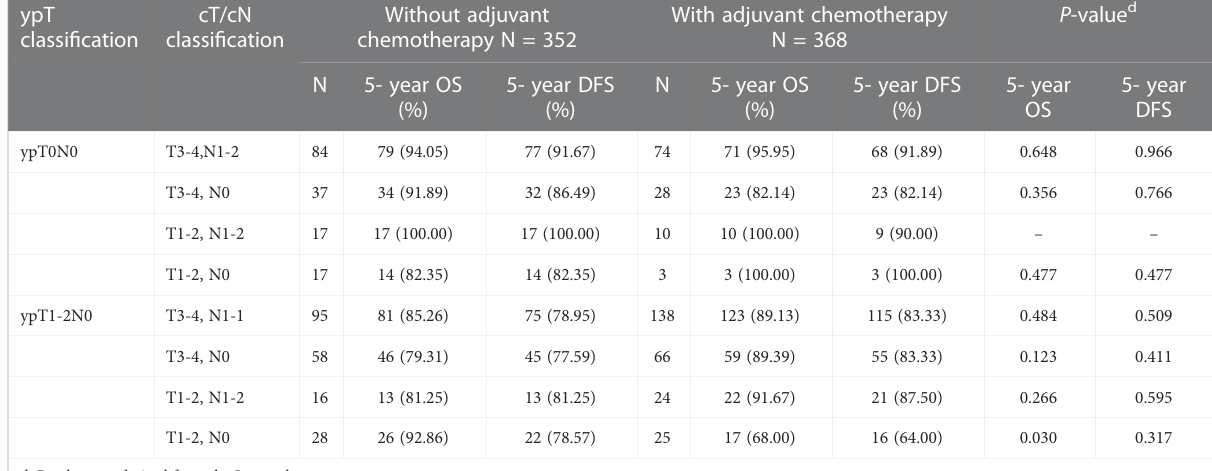
TABLE 3 5-year OS and DFS comparison by different clinicopathological stage and the use of adjuvant chemotherapy of study patients, n =720. ypT cT/cN Without adjuvant classi fi cation classi fi cation chemotherapy N =